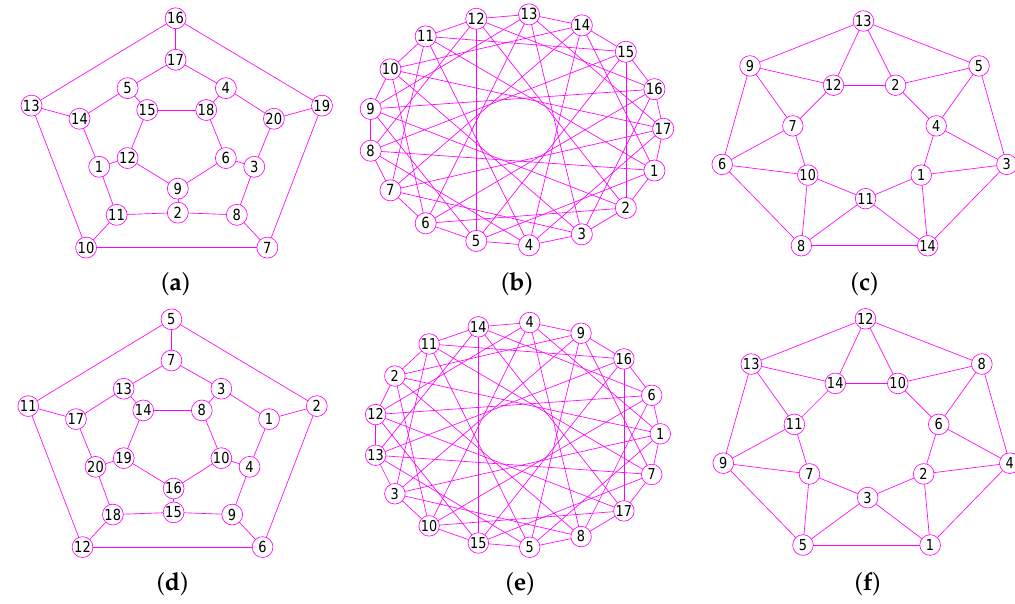
Figure 14. The TopMost graphs of three graphs G 14 , G 15 and G 16 . ( a ) A Hamiltonian Graph G 14 of 20 vertices and 30 edges; ( b ) The 6-Andrásfai graph G 15 of 17 vertices and 51 edges; ( c ) The 7-antiprism graph G 16 of 14 vertices and 28 edges; ( d ) The TopMost graph of G 14 ; ( e ) The TopMost graph of G 15 ; ( f ) The TopMost graph of G 16